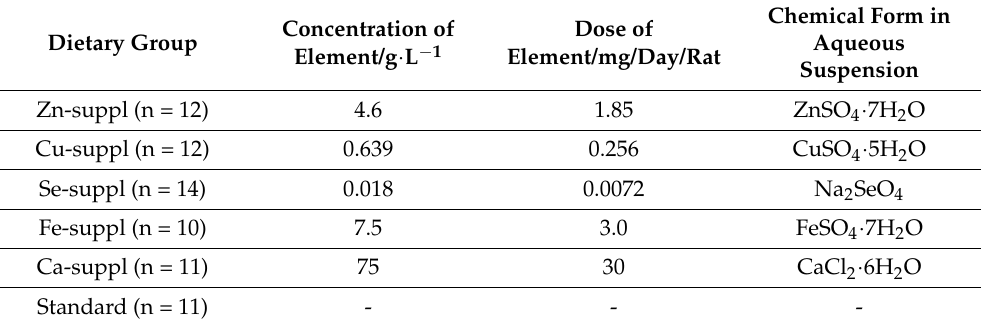
Table 1. Dietary group characteristics. The number of samples from each group is specified in the first column (n). One half of the samples in each dietary group represents the experimental group with implanted cancer cells, whereas the second half represents the control group, except for the Ca and Standard groups, where the division was 5(ctrl) + 6(exp). Concentration of Dietary Group Element/g · L −